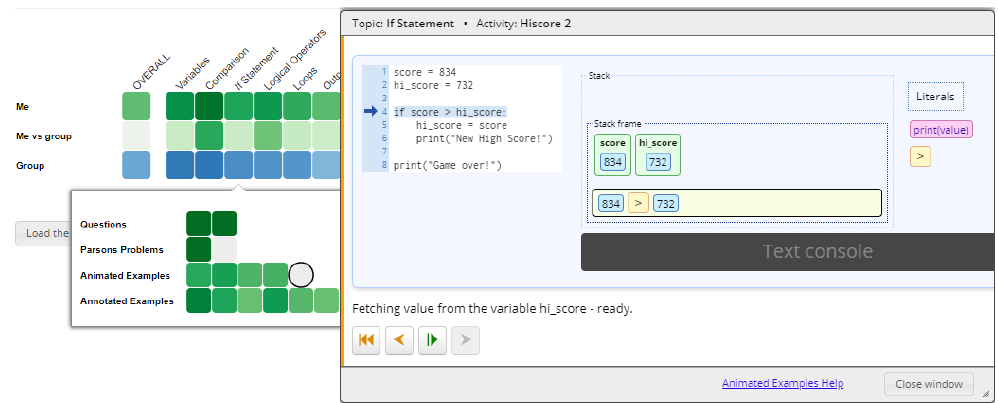
Figure 6. A program visualization (animated example) loaded from the Mastery Grids